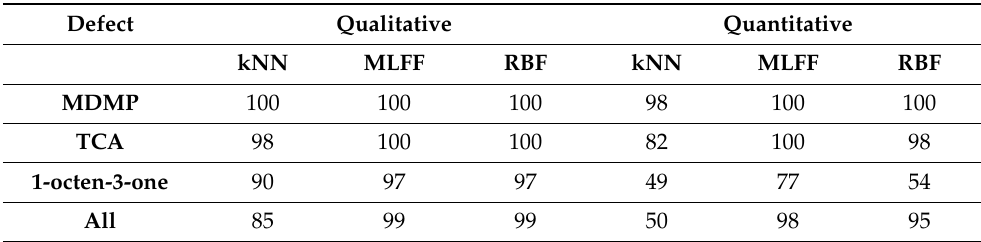
Table 3. Success rate for the different pattern recognition techniques for the offline experiments. Units in percentage.